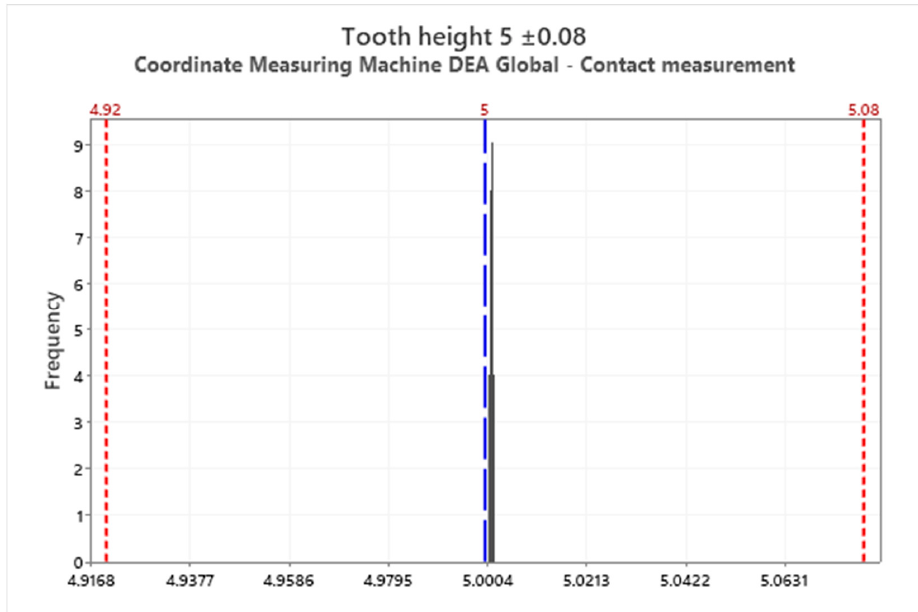
Figure 12. Tooth height 5 ± 0.08 mm—histogram from measurements obtained with the DEA Global Coordinate Measuring Machine, values on x axis given in mm (own study).